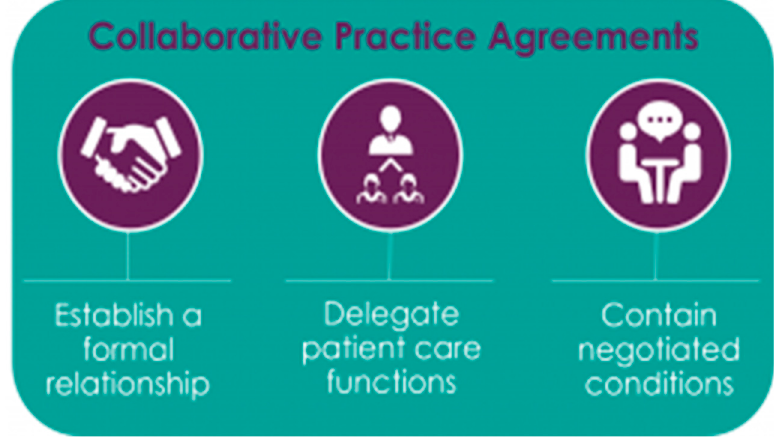
Figure 3. Collaborative Practice Agreement Process [60].